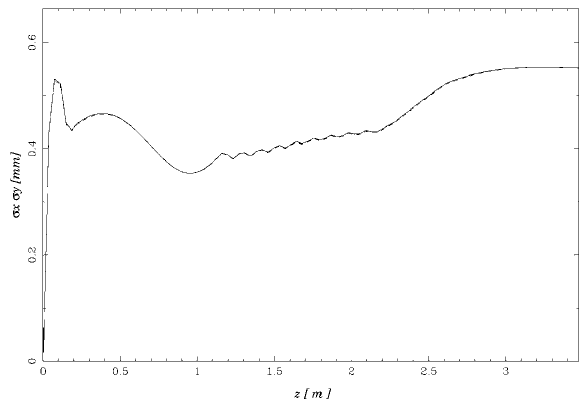
FIG. 5. Transverse beam size as a function of position along the beam line.